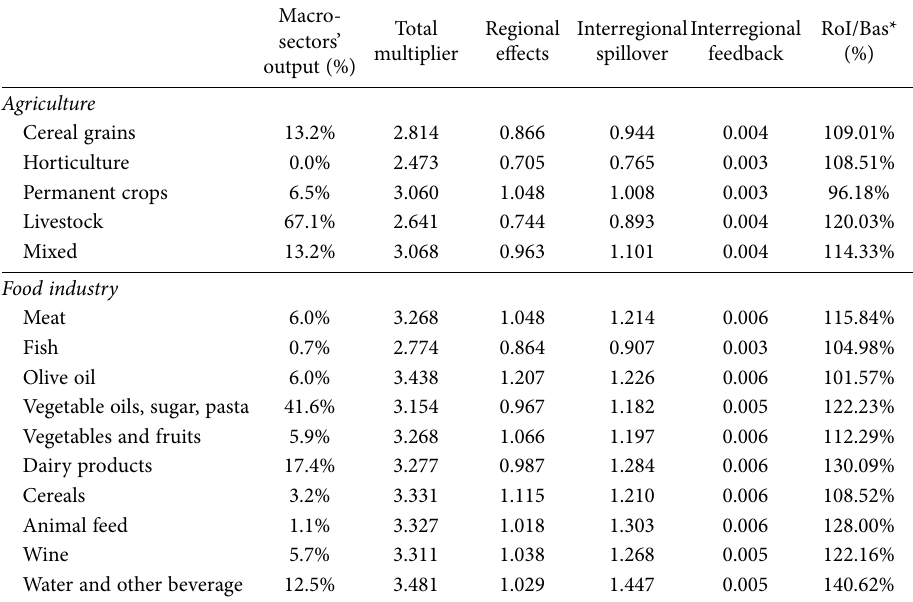
Table 4. Regional breakdown of output multipliers in the agri-food sectors.